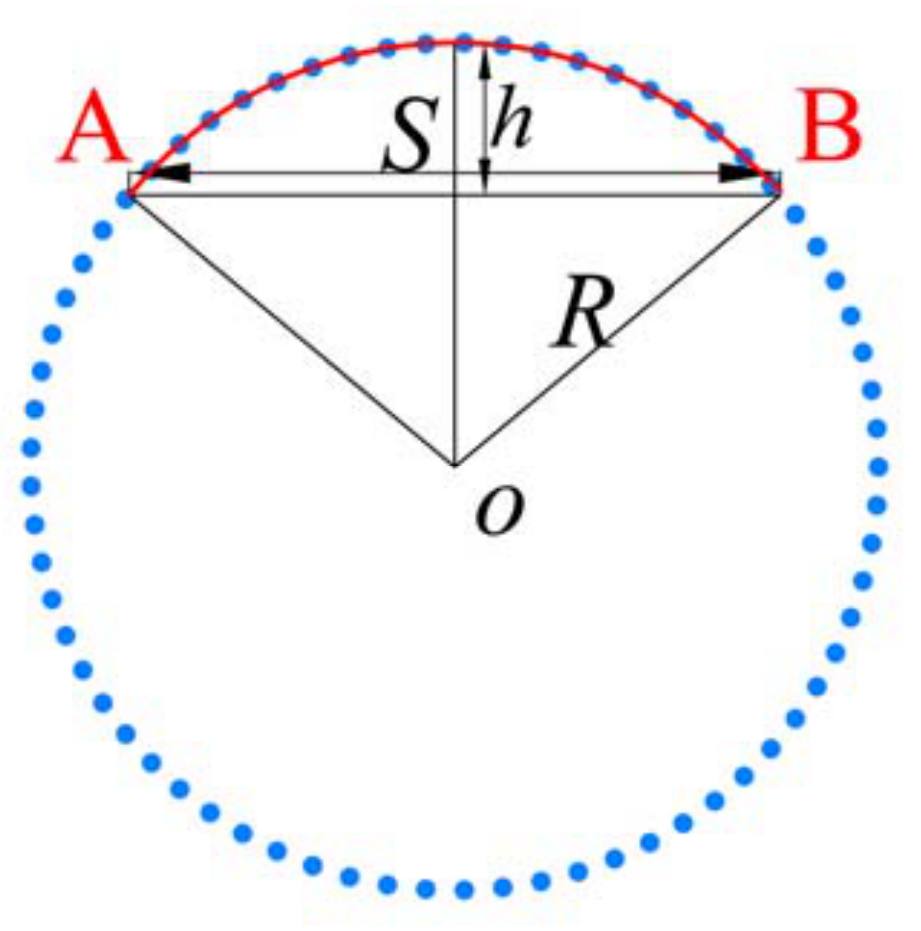
Figure 18. Estimation of the radius of curvature by arch height and chord length.